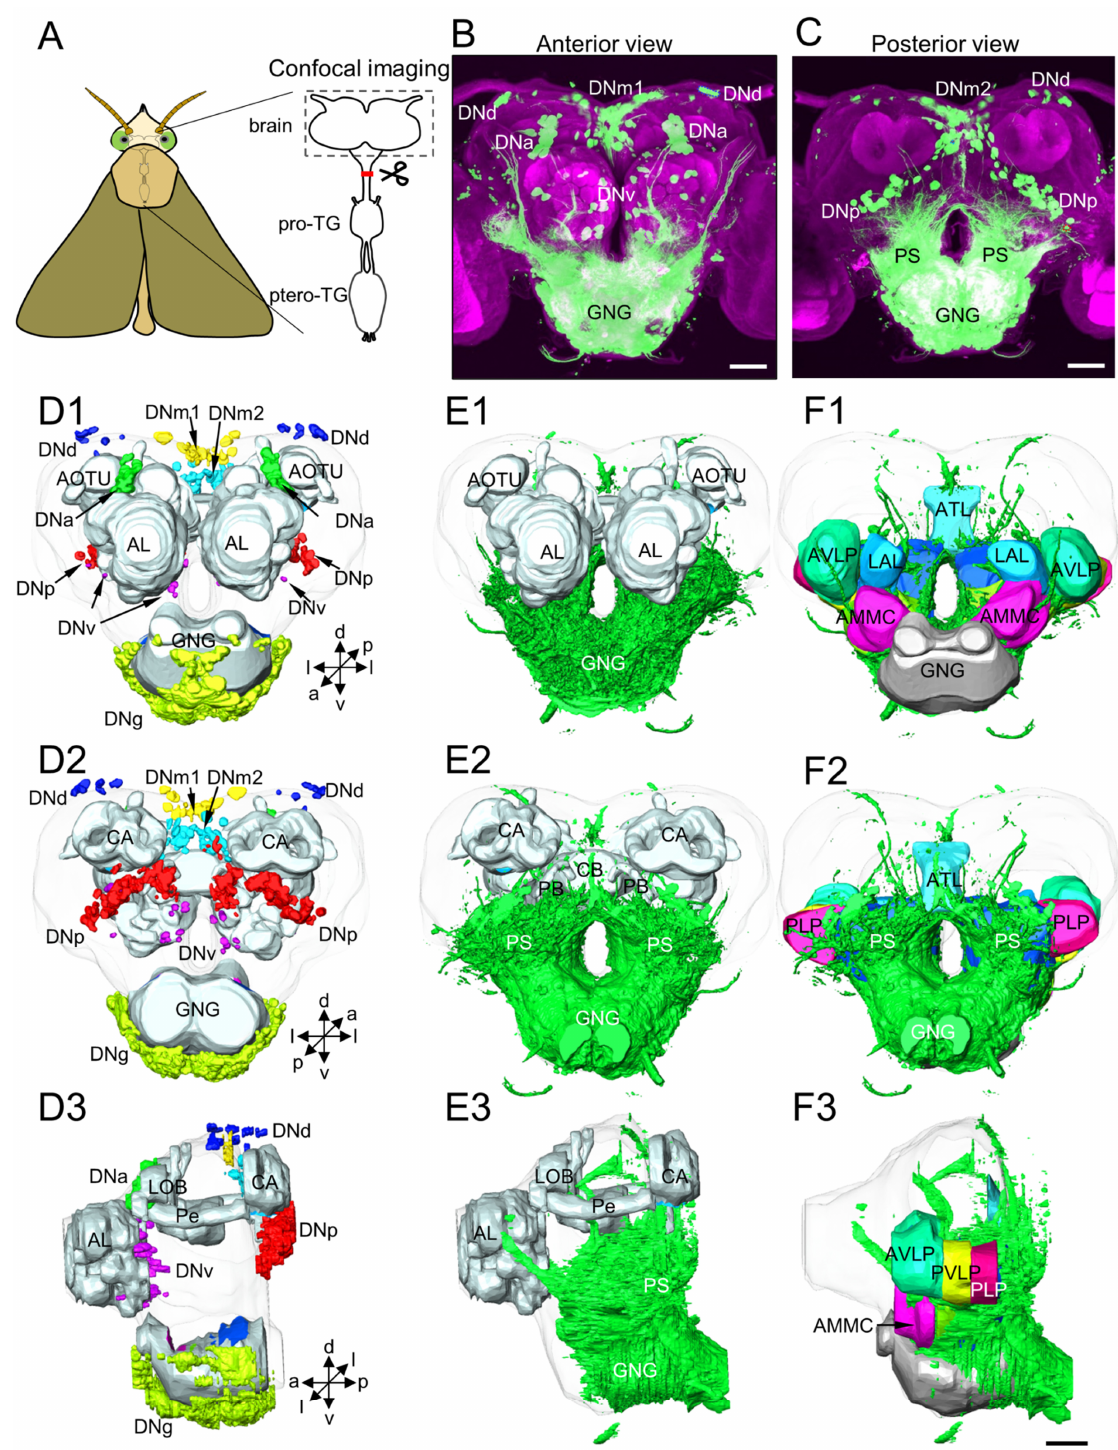
Figure 1. Basic anatomy of descending neurons (DNs) and major innervation areas in the brain of H. armigera : ( A ) schematic of backfilling from the neck connective of H. armigera ; ( B ) anterior view of the brain labeled by backfilling; ( C ) posterior view of the brain labeled by backfilling; ( D1 – D3 )